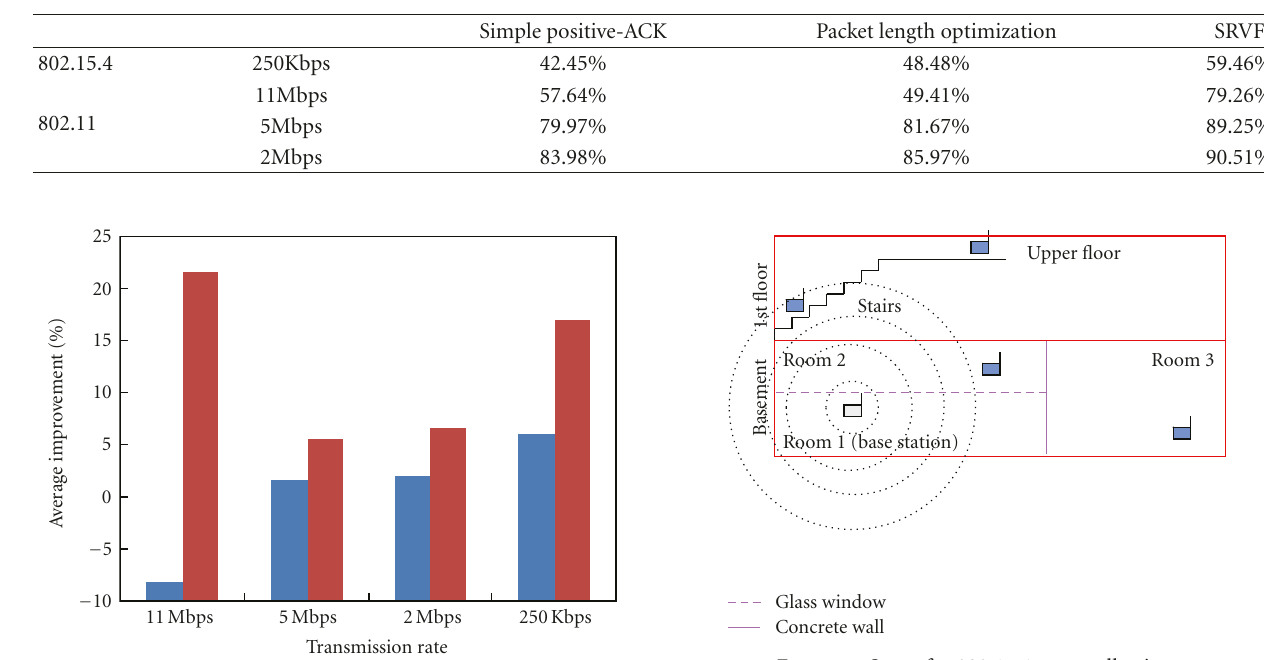
Table 2: Empirical energy e ffi ciency.